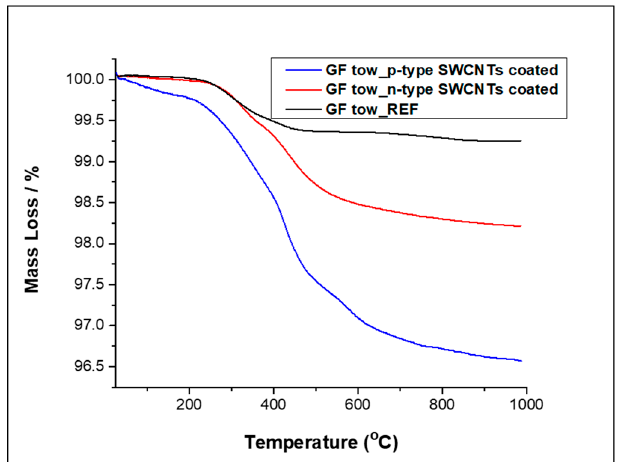
Figure 5. Thermogravimetric measurements of uncoated GFs, coated GFs with p-type and n-type SWCNTs, respectively.